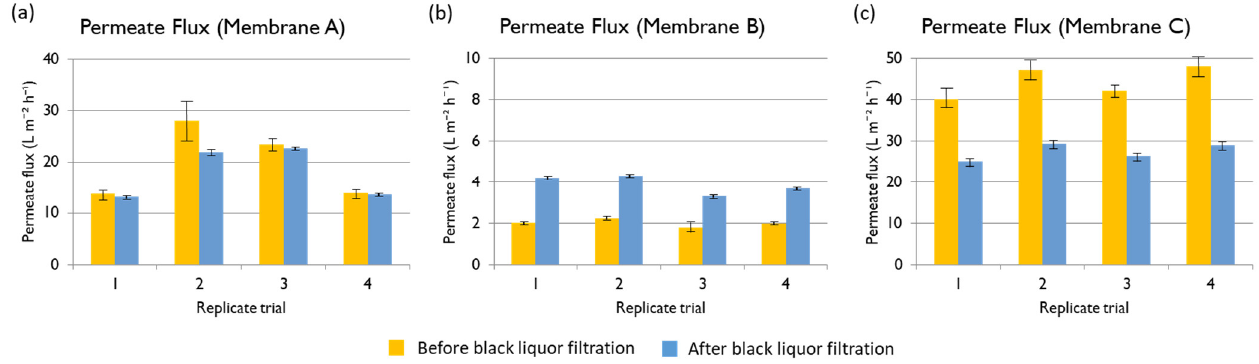
Figure 6. Permeate flux of Membranes A ( a ), B ( b ) and C ( c ) at standard conditions before and after the permeation of black liquor.